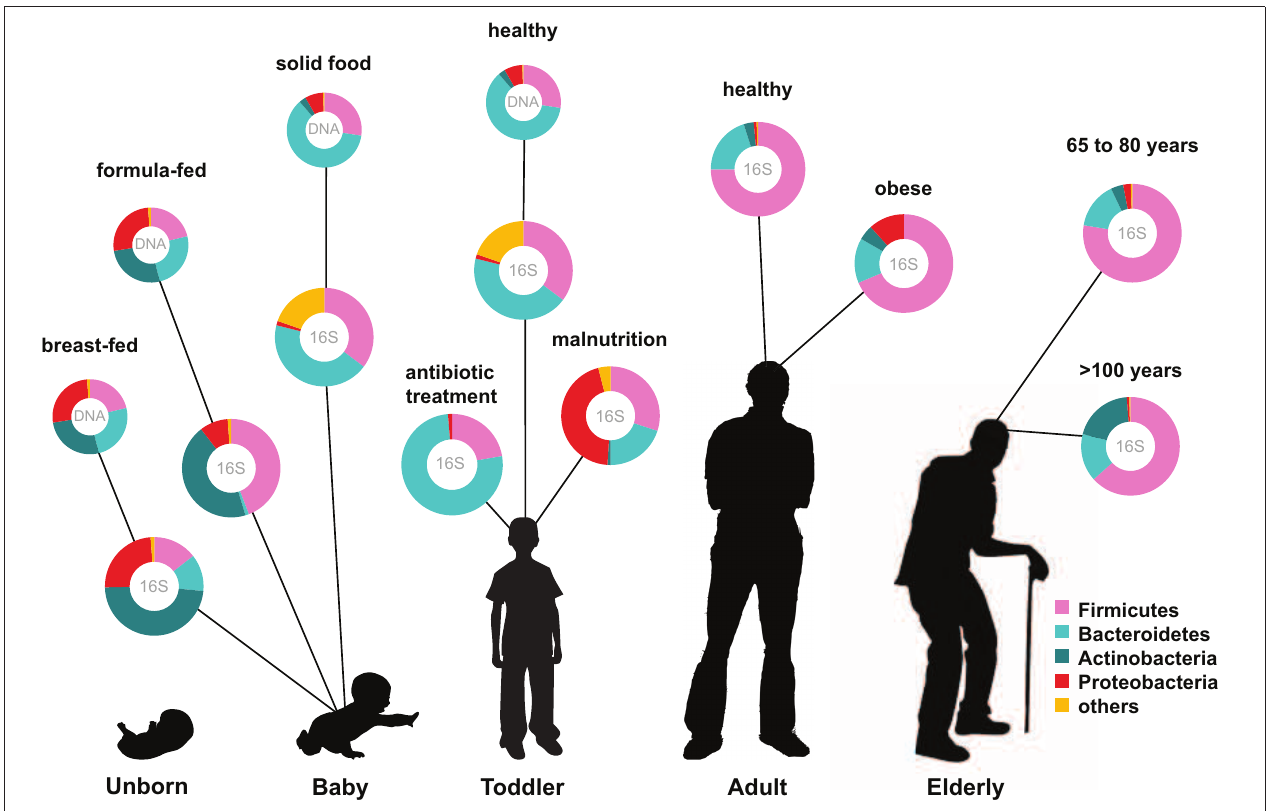
FIGURE 1 | Human microbiota: onset and shapingthrough life stagesand perturbations. Thegraphprovidesaglobaloverviewoftherelative abundance of key phyla of the human microbiota composition in different stages of life. Measured by either 16S RNA or metagenomic approaches (DNA). Data